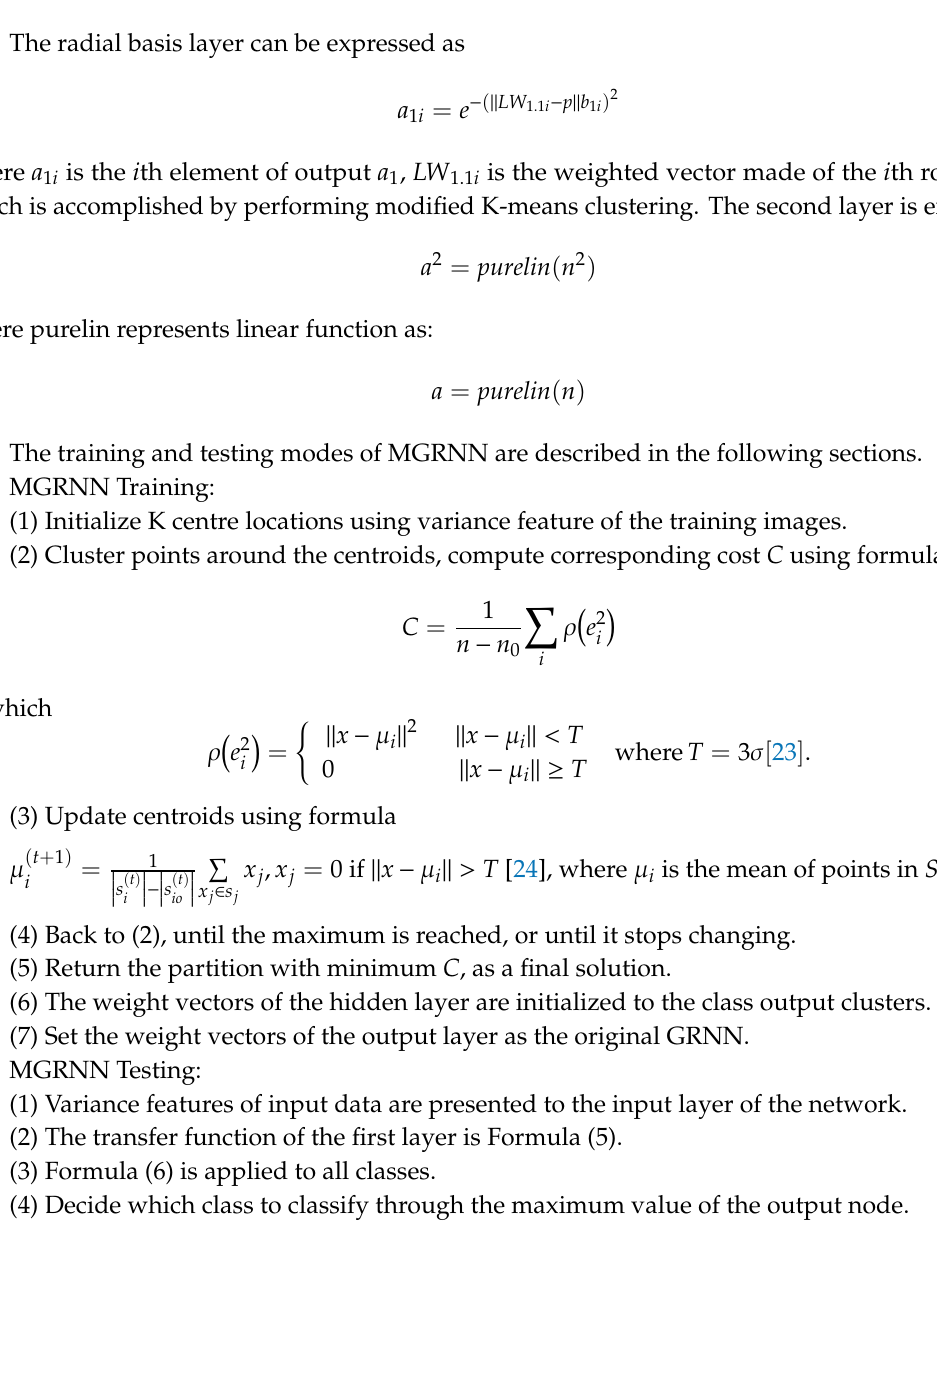
Figure 8. The architecture of MGRNN.